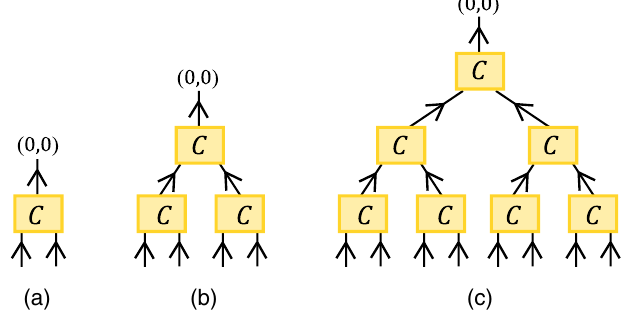
FIG. 8. CHSH trees. Contracting many copies of connector (19) according to a tree network and inputting (0,0) on the top connector, we obtain Bell inequalities for n ¼ 2 , 4, 8 parties. The minimum nonsignaling value of inequalities (a), (b), (c) are, respectively, − 0 . 5 , − 1 . 5 , − 7 . 5 .